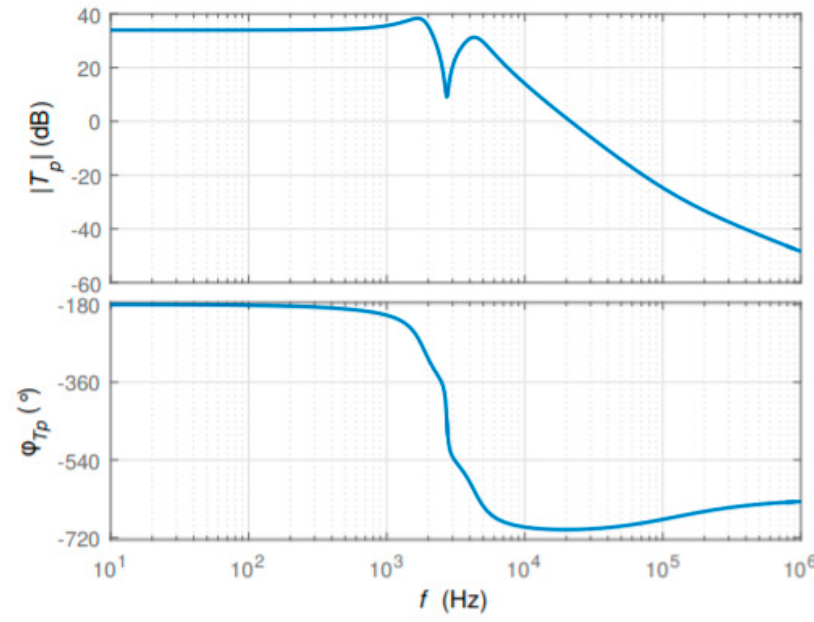
Figure 20. Theoretically derived G vd for a non-ideal Cuk converter [4].